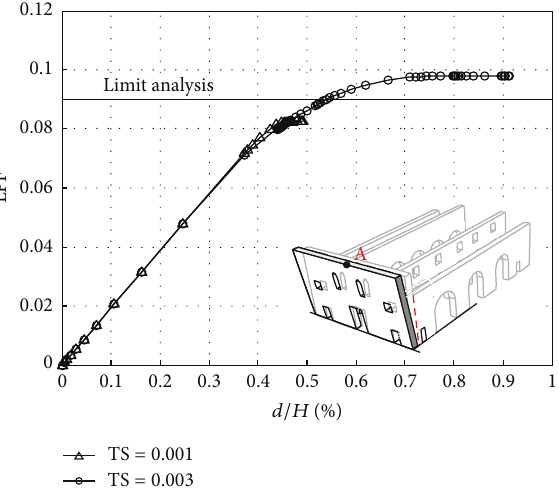
Figure 11: Mechanism 1: comparison between nonlinear FE analysis and limit analysis for the out-of-plane collapse of the fac¸ade.